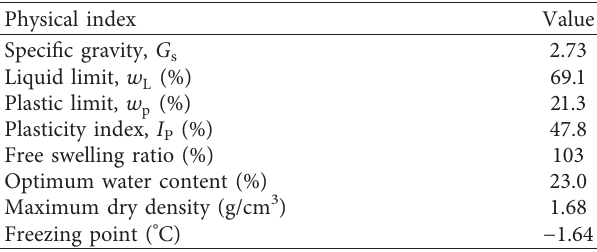
Table 2: Physical properties of expansive soil